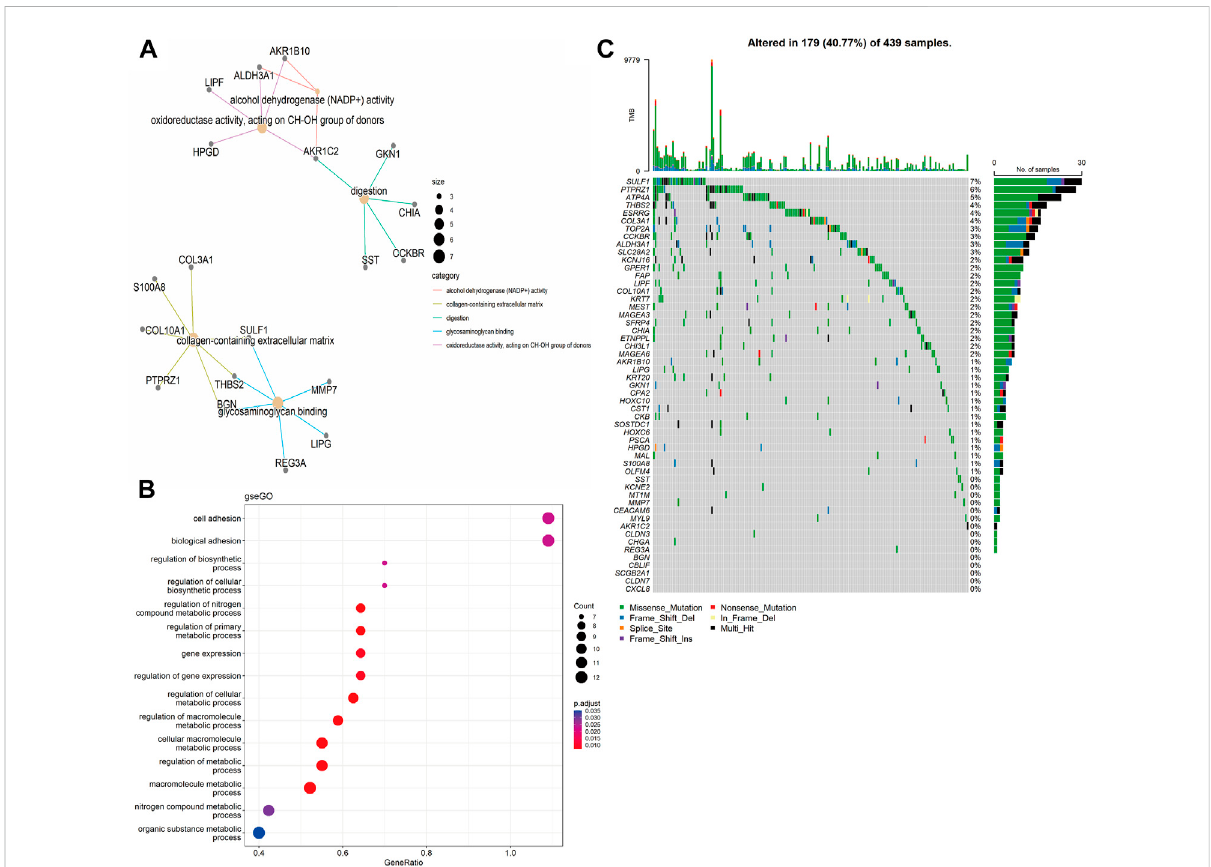
FIGURE 3 Enrichment analysis. (A) GeneOntology (GO)-tree analysis; (B) gesGO pathwayenrichmentanalysis (C) The mutation landscapeofkeyDEGs in TCGA-STAD